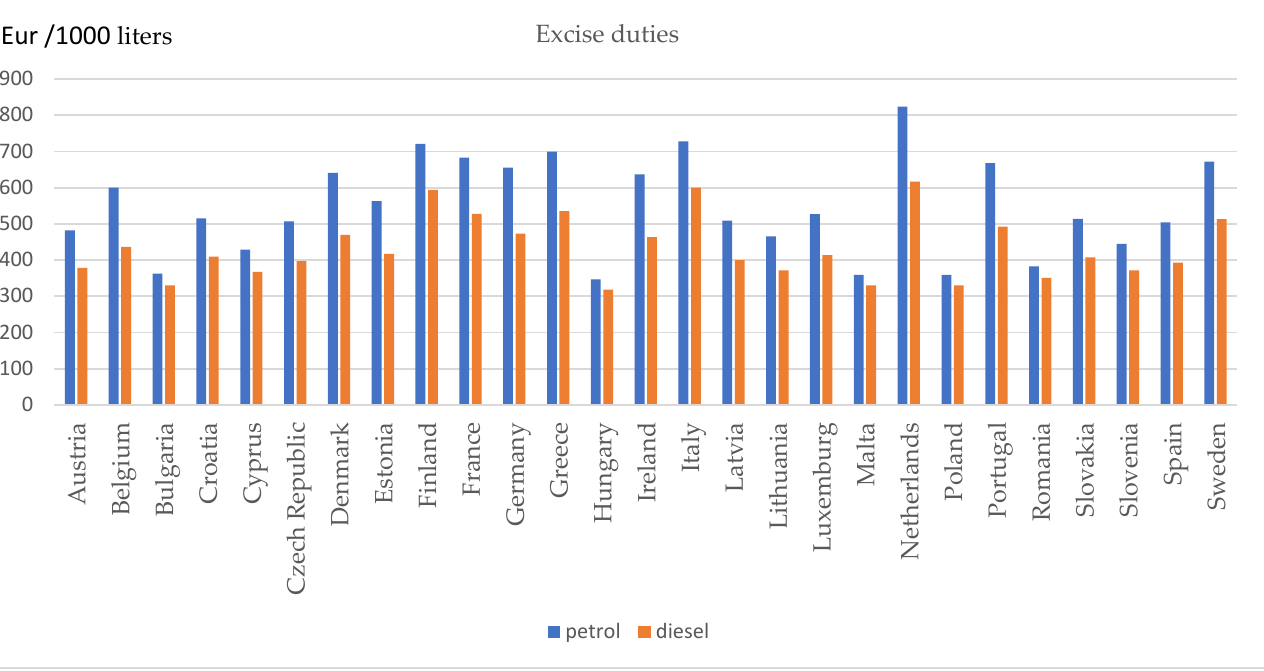
Figure 9. Excise duties in EU countries. Source: own elaboration. Data from [66,67].